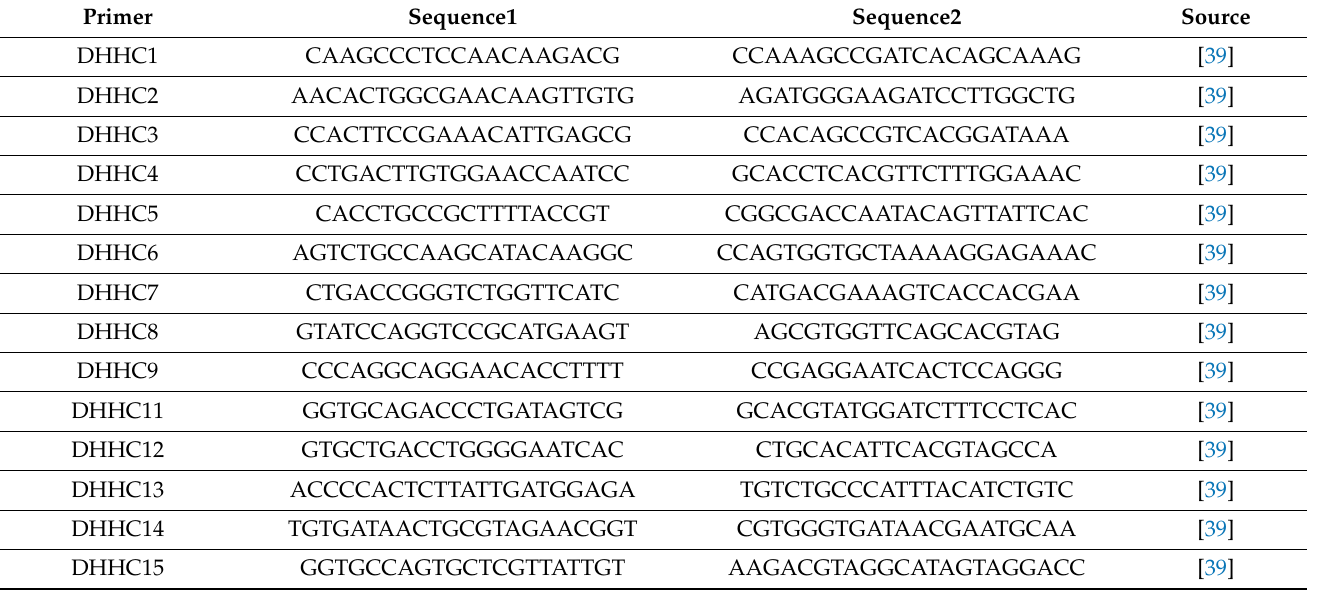
Table 3. Real-time primers